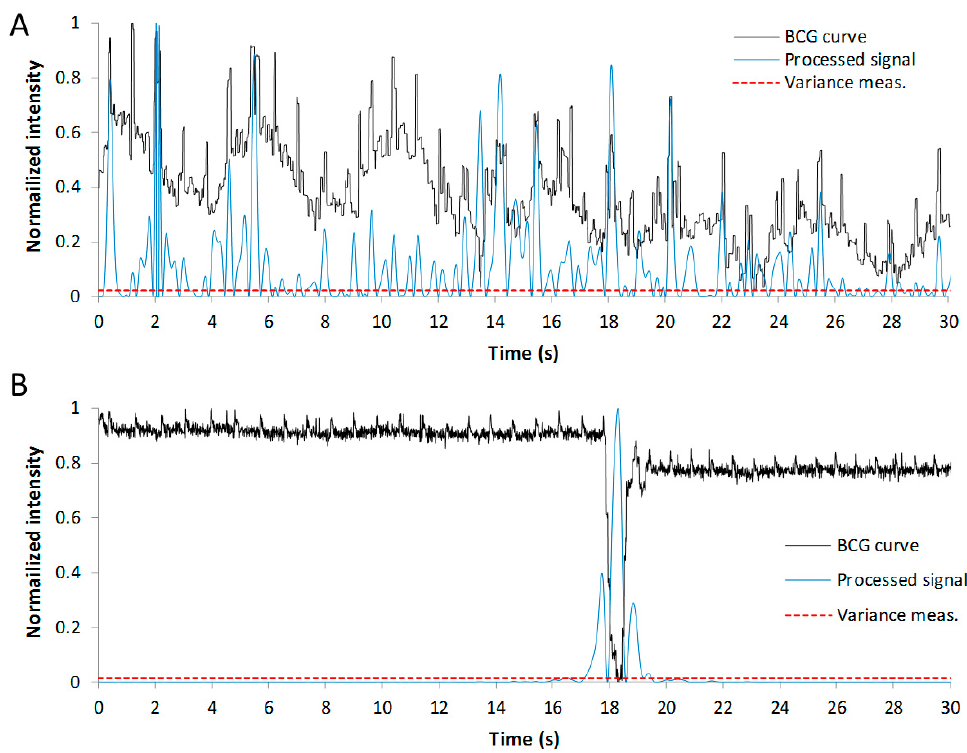
Figure 9. Clean ( A ) and corrupted ( B ) BCG curves (in black). Blue and red lines correspond to the data used for the prediction of movements in the sequence.